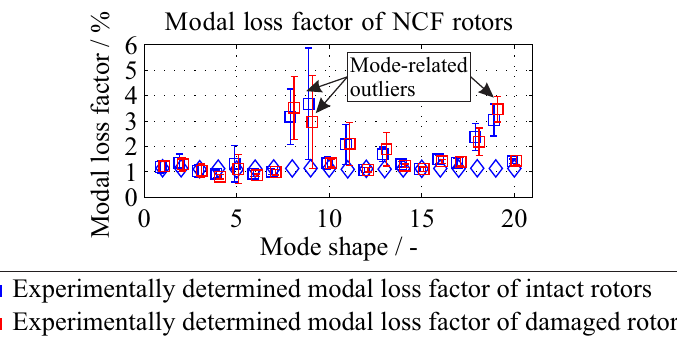
Figure 13. Comparison between the experimentally identified and numerically calculated modal loss factors for the investigated